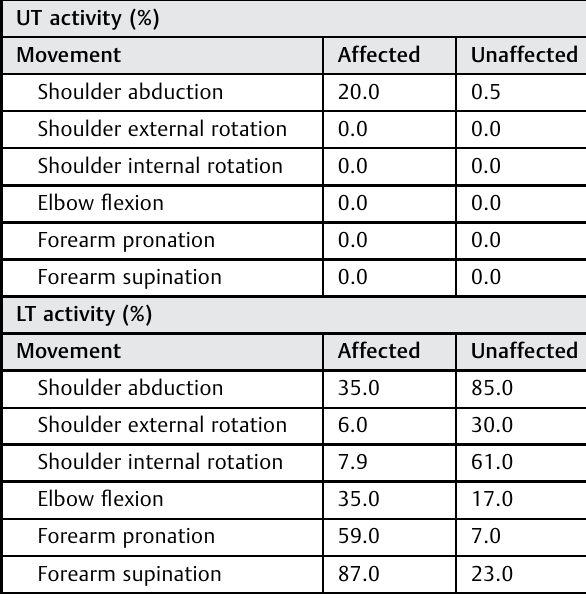
Table 2 Percentage of EMG activity contributed by the UT and LT in the six tested movements in both affected and